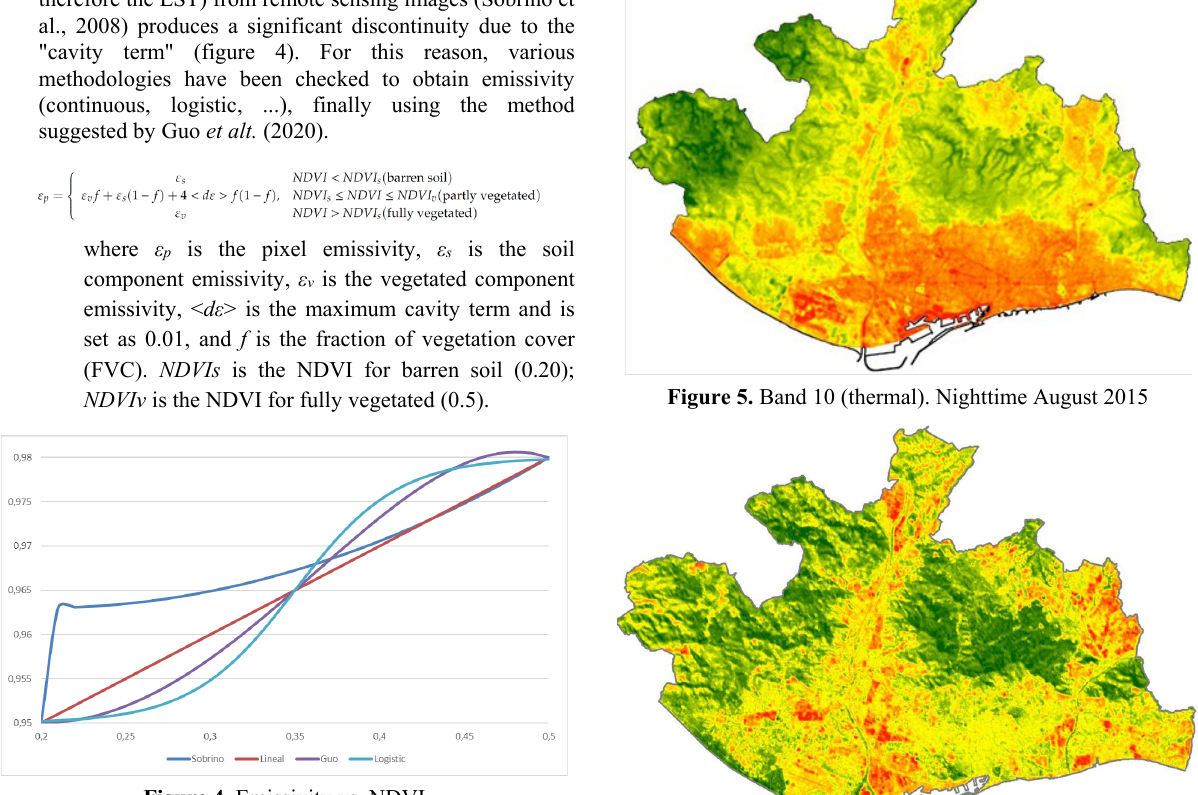
Figure 4. Emissivity vs. NDVI